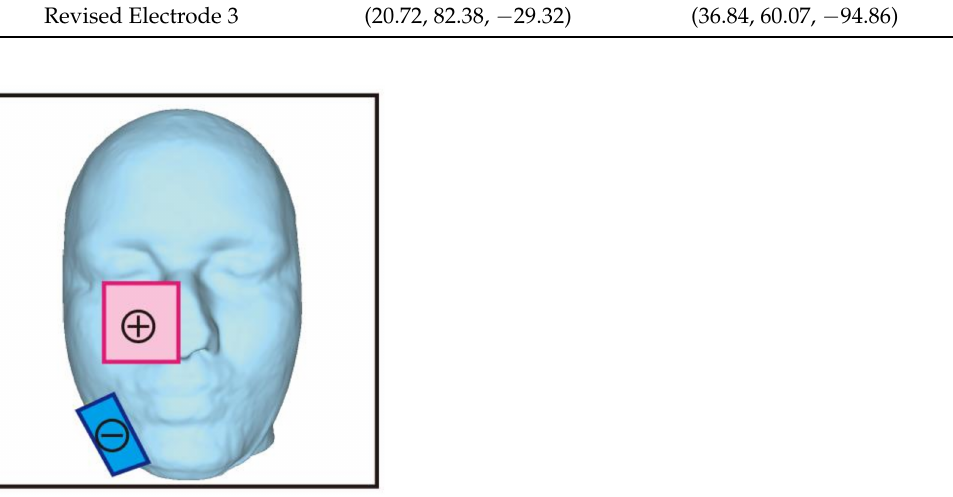
Figure 9. Revised electrode placement that stimulates the lower central area of the right